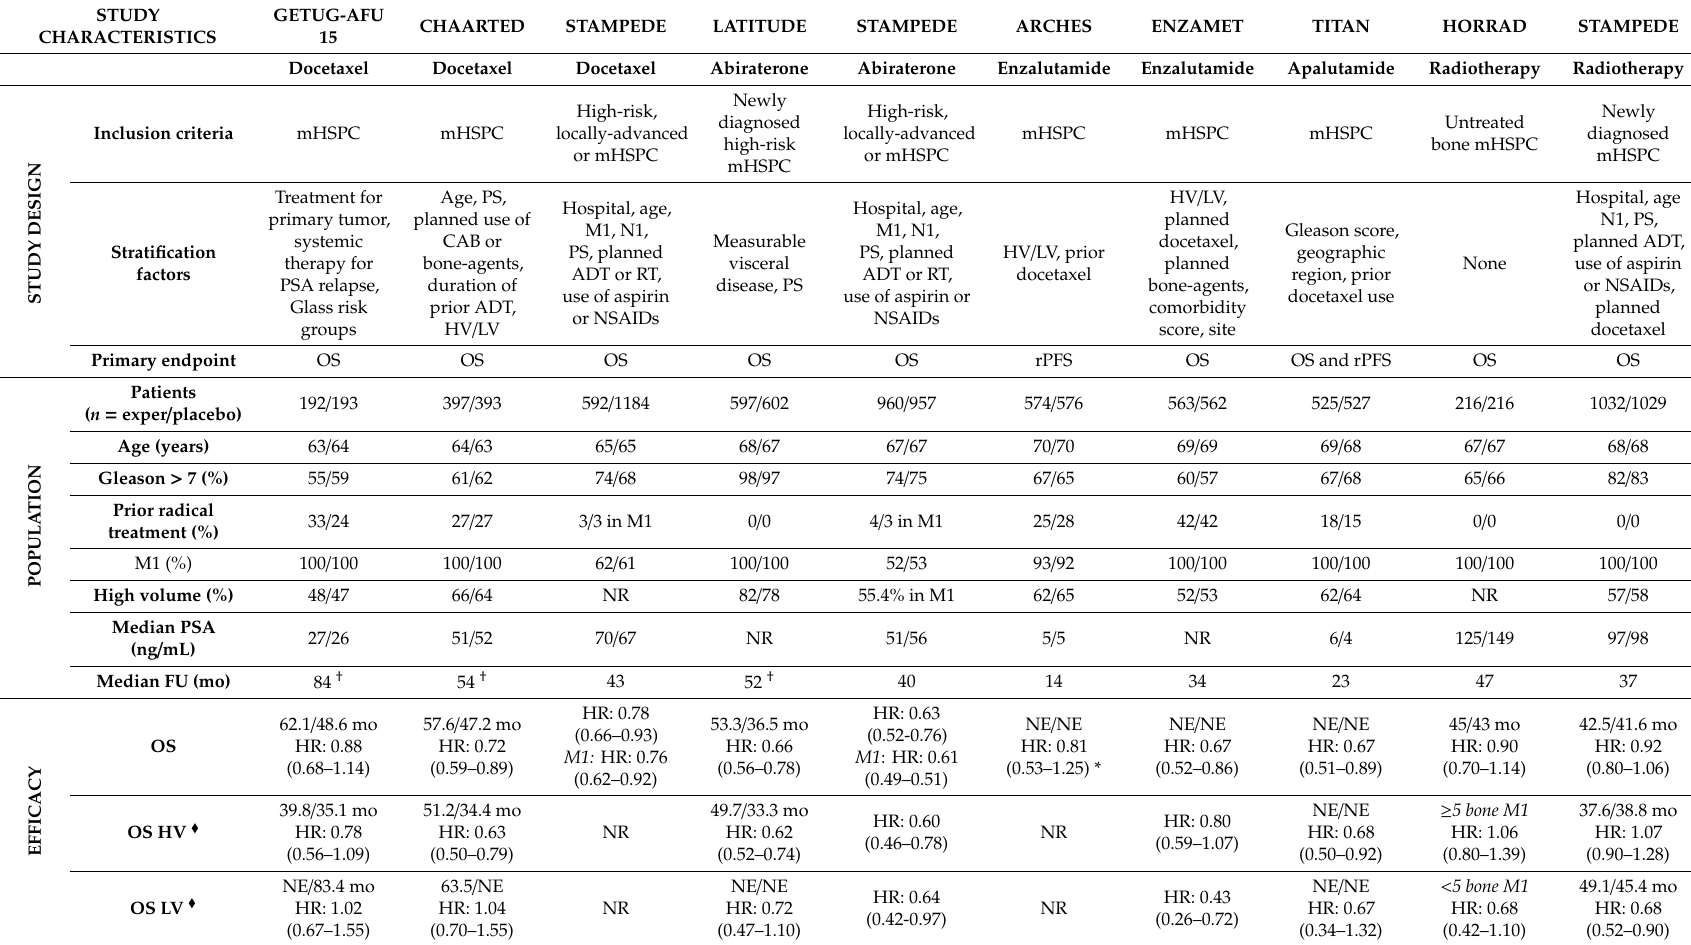
Table 3. Summary of phase 3 randomized controlled trials in metastatic hormone-sensitive prostate cancer